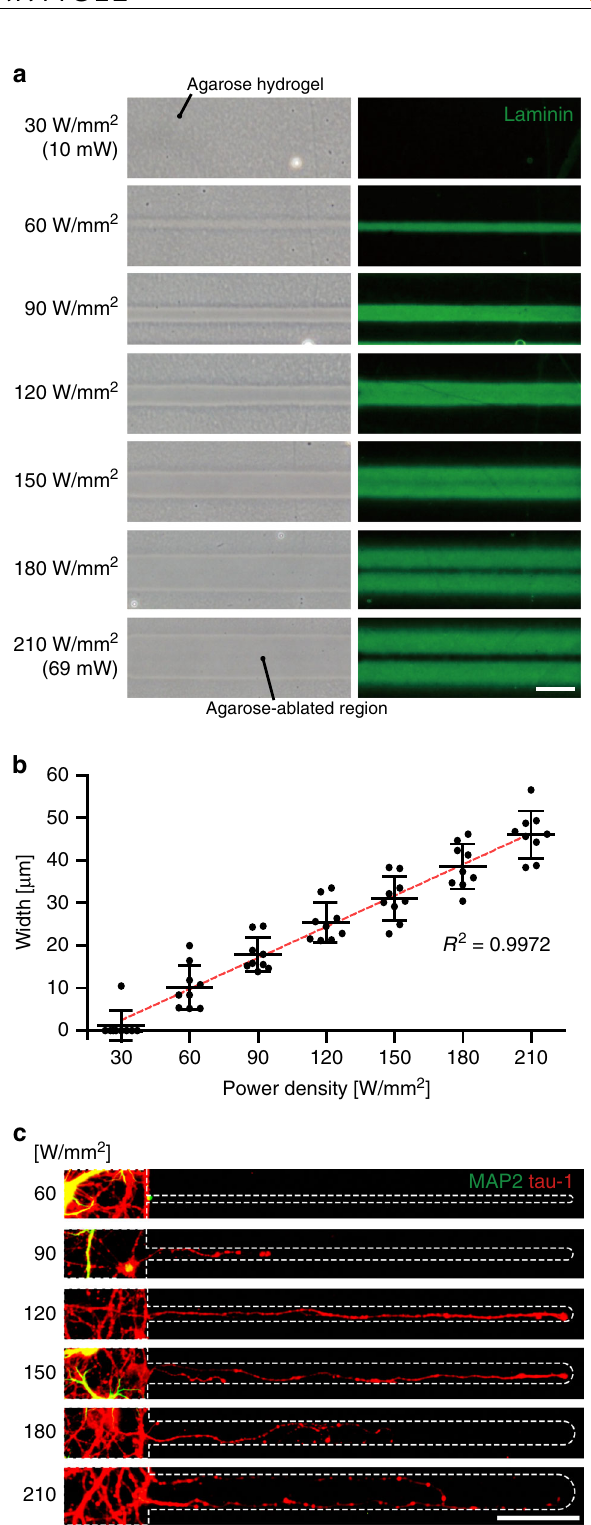
Fig. 2 Thermoplasmonic ablation of agarose hydrogel and neurite outgrowth. a Phase-contrast and anti-laminin staining images of ablated regions with different laser power densities. The green region indicates intact laminin, which was originally below the hydrogel and then revealed after agarose ablation. Scale bar: 50 μ m. The images shown are representative of three independent experiments. b Ablated width of agarose hydrogel against power density. n = 9 ablated lines. Data are presented as mean ± SD. c Immunostained images of extended neurites along the ablated lines (green: MAP2, somatodendritic marker; red: tau-1, axonal marker). Scale bar: 100 μ m. The images shown are representative of two independent experiments. Source data are provided as a Source Data fi